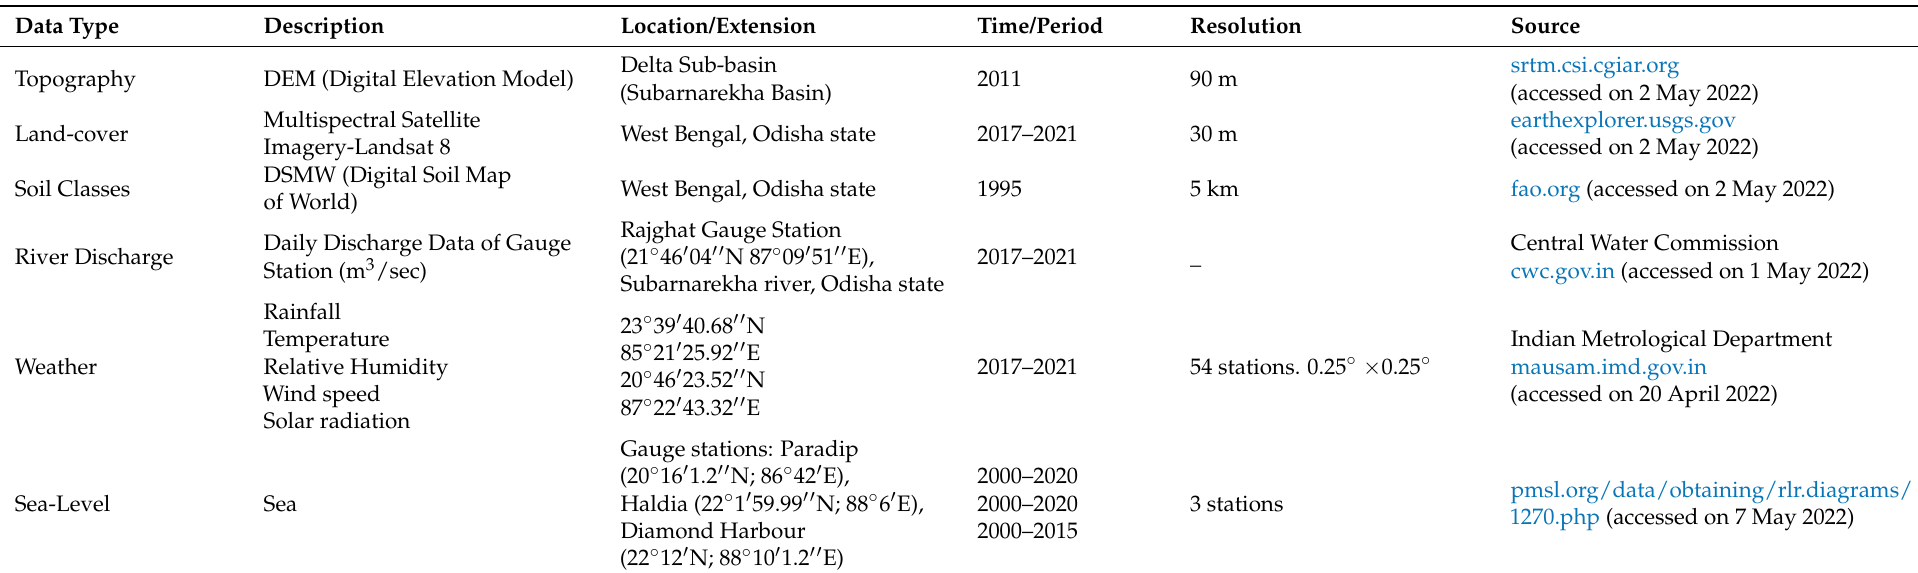
Table 1. Data sources for simulation of the SWAT